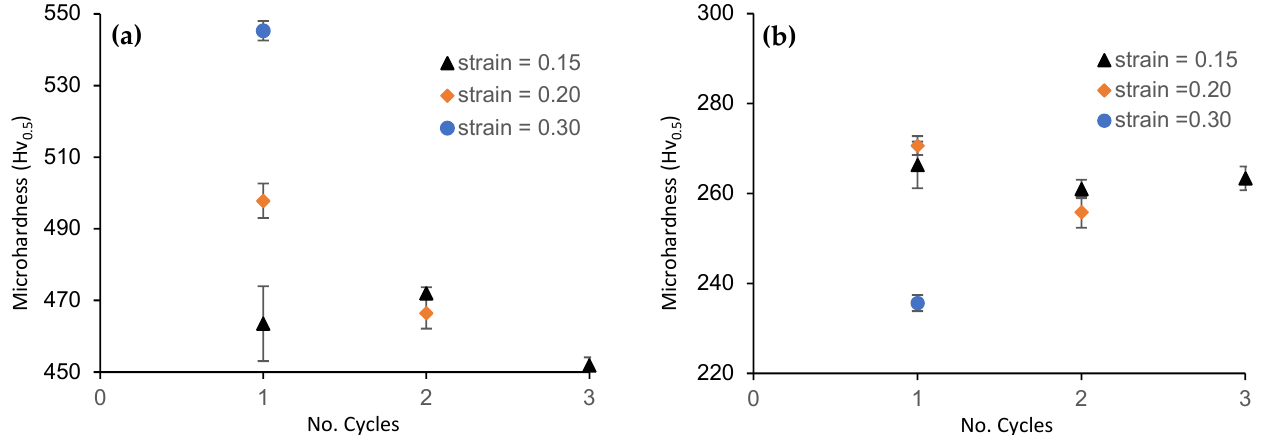
Figure 11. Microhardness measurements for samples processed using TMP: ( a ) deformed samples and ( b ) annealed samples.